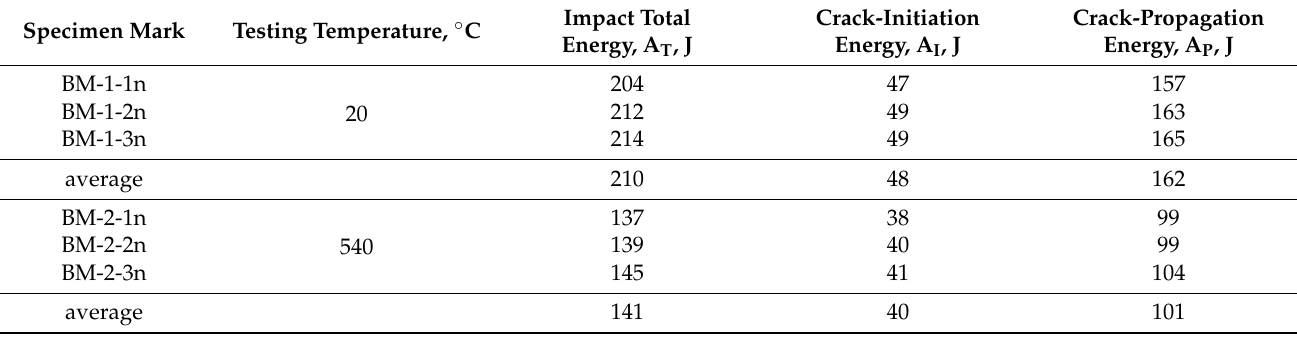
Table 7. Results of impact testing for A387 Gr. B—BM [13].